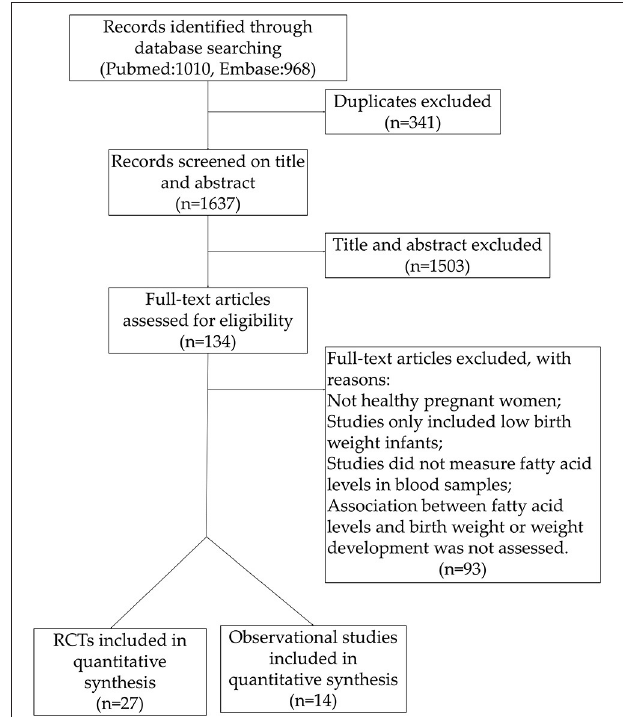
FIGURE 1 | Study flow